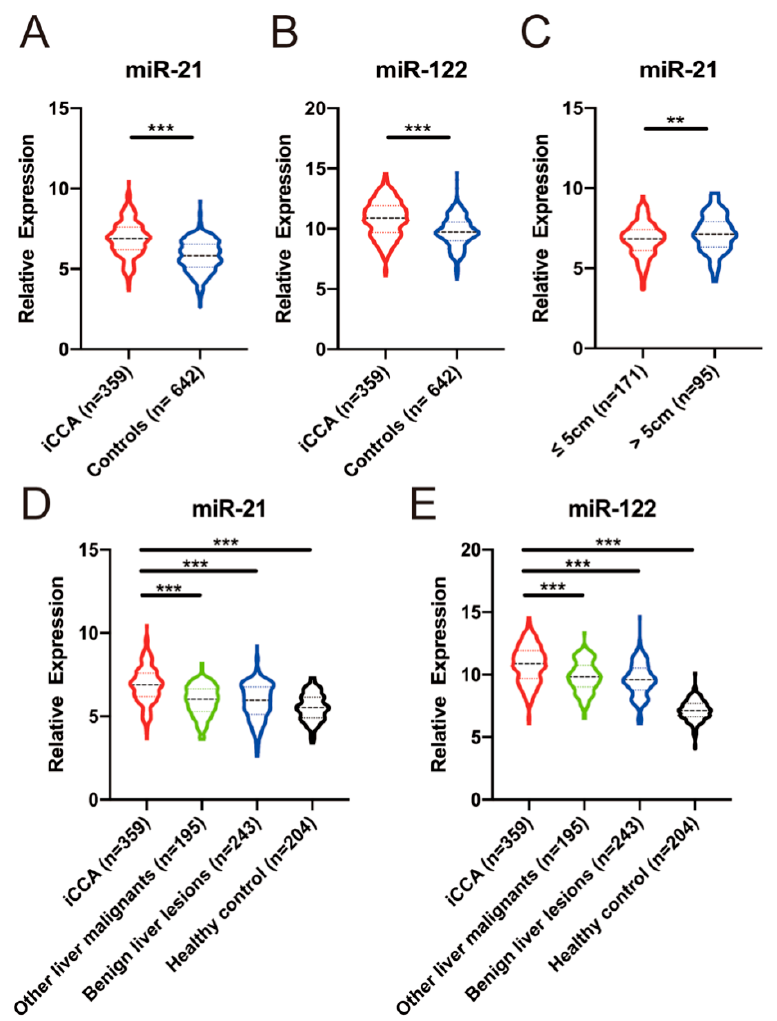
Figure 2. Relative expression of plasma miR-21 and miR-122 in iCCA and control patients. ( A , B ), The relative expression of plasma miR-21 and miR-122 in iCCA patients was significantly higher than that in control ( p < 0.001). ( C ) The relative expression of plasma miR-21 in iCCA patients with > 5cm tumor size was significantly higher than iCCA patients with ≤ 5 cm tumor size ( p = 0.009). ( D , E ), The relative expression of plasma miR-21 and miR-122 in iCCA patients was significantly higher than that in healthy, benign liver lesions, and other liver malignancies (all p < 0.001). **, p < 0.01; ***, p < 0.001.